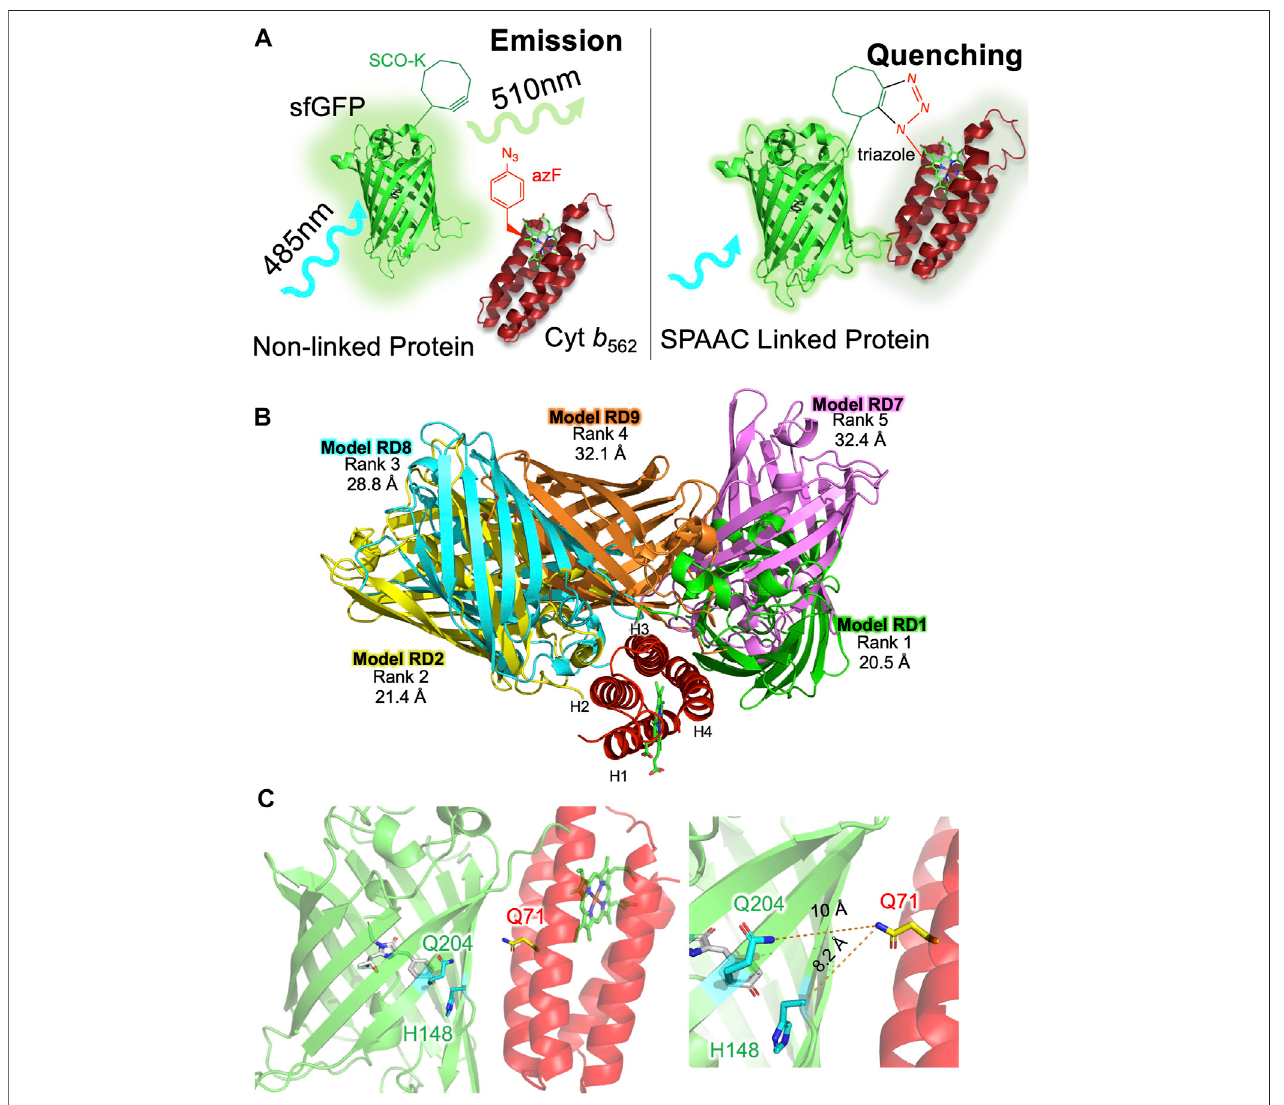
FIGURE1| DesigningsfGFP-cyt b 562 SPAAClinkedheterodimers. (A) BasicstrategyforconstructingheterodimersusingSPAAC.Asamonomericprotein,sfGFP (green) will excite at ∼ 485 nm and then emit light at ∼ 510 nm. On forming a heterodimer, sfGFP fl uorescence will predominantly be quenched by cyt b 562 (red). The complexwill only persist ifSPAAC issuccessful and atriazolelinkisformed. (B) Thetop fi ve alignments ofsfGFP (various colours) and cyt b 562 (red) ranked accordingto total energy of interaction by RosettaDock. Distances measured between each model chromophore pair are shown below the rank. Model RD1 has the closest chromophore proximity and lowest total energy. (C) Residue selected for mutation to SCO-K (Q204 and H148; green) in sfGFP or AzF (Q71; red) in cyt b 562 .